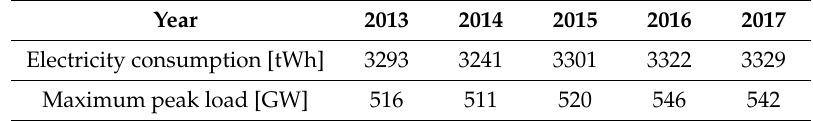
Table 1. European electricity consumption and maximum peak loads between 2013 and 2017